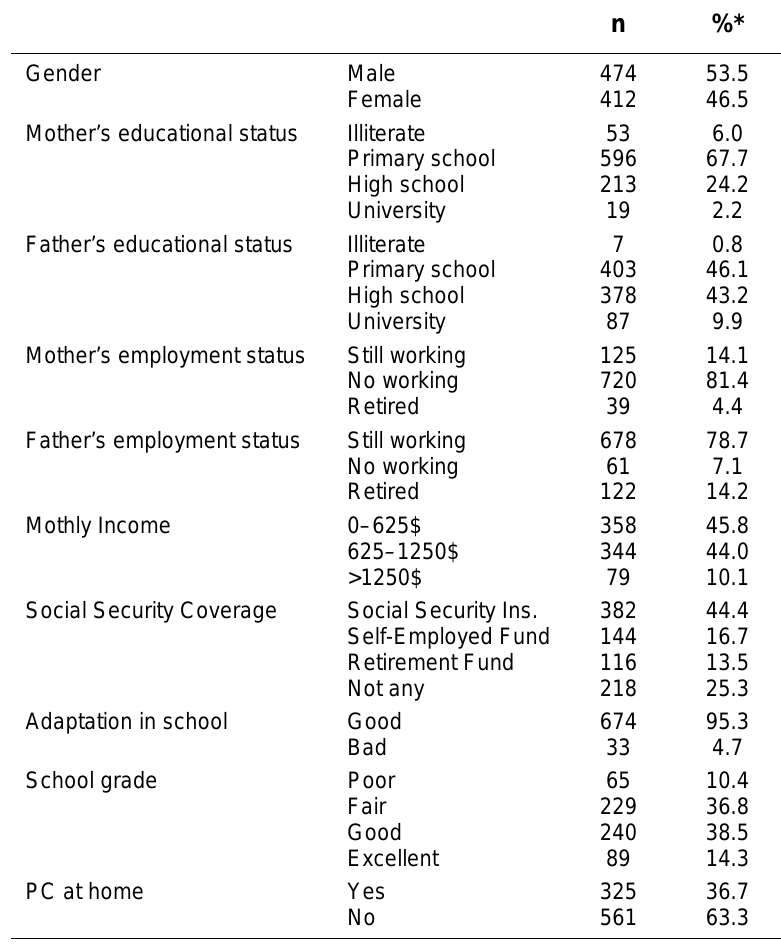
Sociodemographic Characteristics of the Study